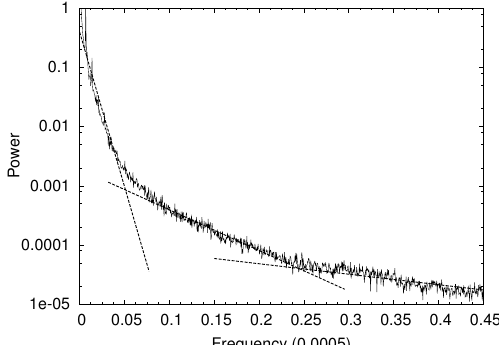
Figure 6. The curve of S((cid:49)n) for embedding dimensions m = Fig. 6. The curve of S (∆ n ) for embedding dimensions m =14 , 15 . Figure 7. The power spectrum of wind speed time series as a Fig. 5. The local slopes D 2 ( (cid:15),m ) for the wind speed time series Fig. 7. The power spectrum of wind speed time series as a function 14 , 15. The maximum Lyapunov exponent of the time series is the The maximum Lyapunov exponent of the time series is the slope of function of frequency at location latitude: 34.98420 ◦ N longitude: with τ = 85 and m ranging from 14 to 16 showing a plateau for of frequency at location Latitude: 34.98420 Longitude: -104.03971. the dashed line 0 . 15 0 . 006 . slope of the dashed line 0 . 15 ± 0 . 006. small values of (cid:15) and giving an estimate of D 2 =1 . 656 Broadband and exponential decay of the power with frequency are 0 . 008 . 104.03971 ◦ W. Broadband and exponential decay of the power with ± ± typical characteristics of chaotic signals. frequency are typical characteristics of chaotic